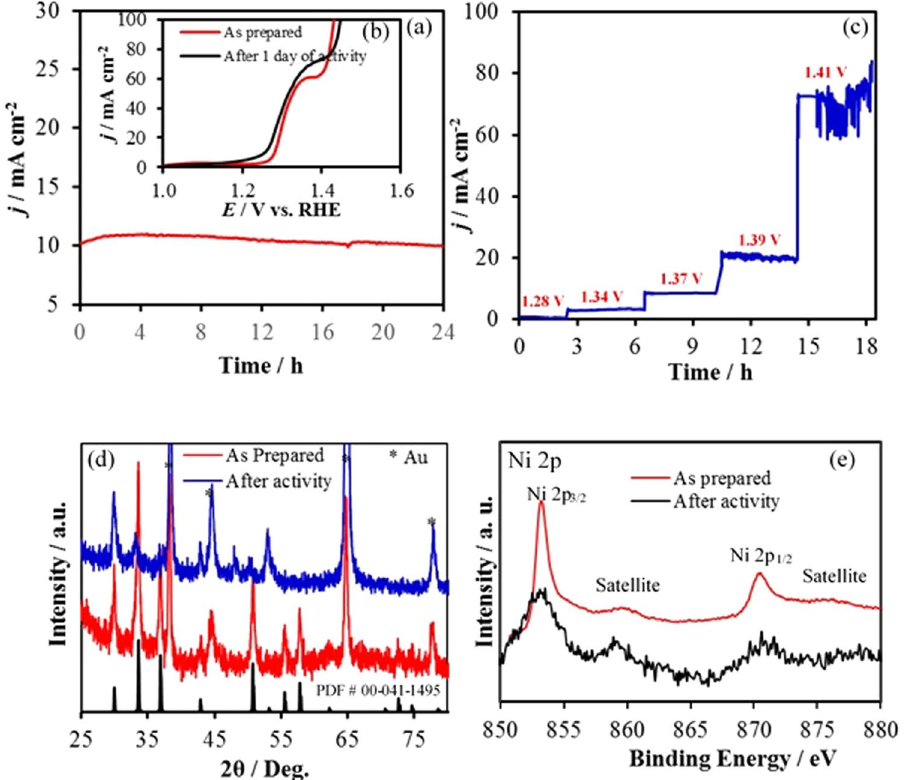
Figure 4. ( a ) Stability study of catalyst under continuous O 2 evolution at a constant potential to achieve 10 mA cm − 2 for 24 h, ( b ) LSVs of catalyst in N 2 saturated 1.0 M KOH before and after chronoamperometry for 24 h, ( c ) Stability of catalyst at different potential by using potential step method. ( d ) XRD patterns before and after current transient experiment for 24 h and ( e ) XPS spectra before and after of